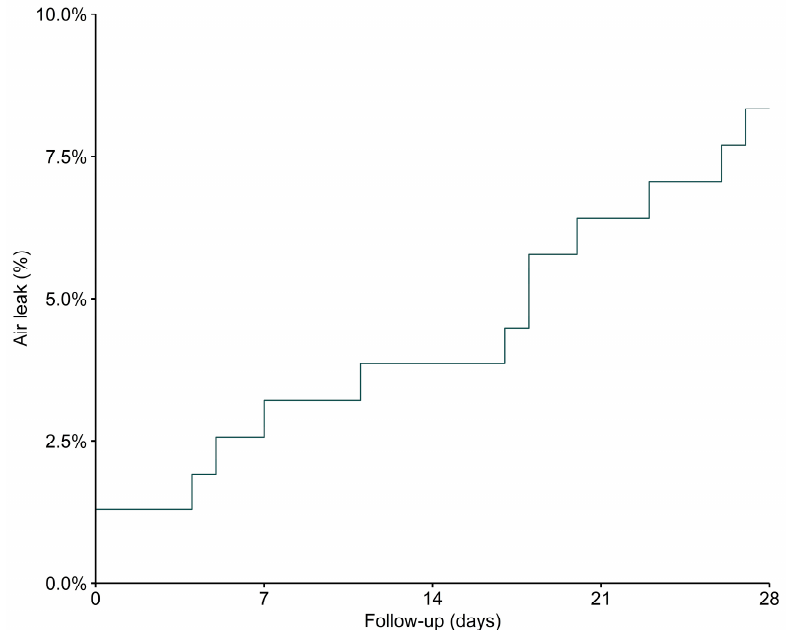
Figure 3. Time to first confirmation of an air leak. Time from ICU admission to first detection of an